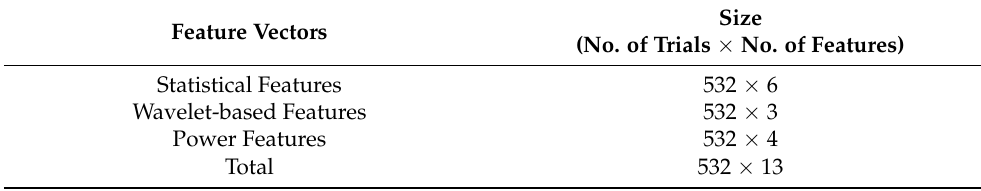
Table 1. Feature vectors classifying motor execution (ME) versus motor imagery (MI).